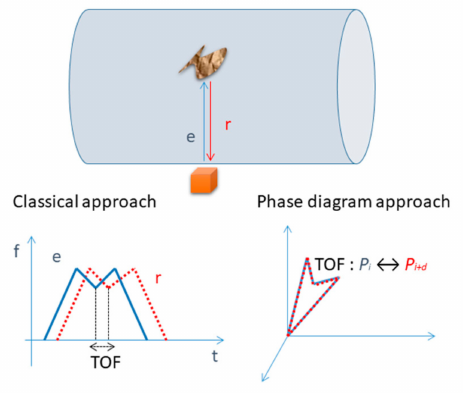
Figure 7. TOF estimation: classical approach versus phase diagram approach; the estimation of TOF is done using the delayed samples between the marks of emitted and received signals,